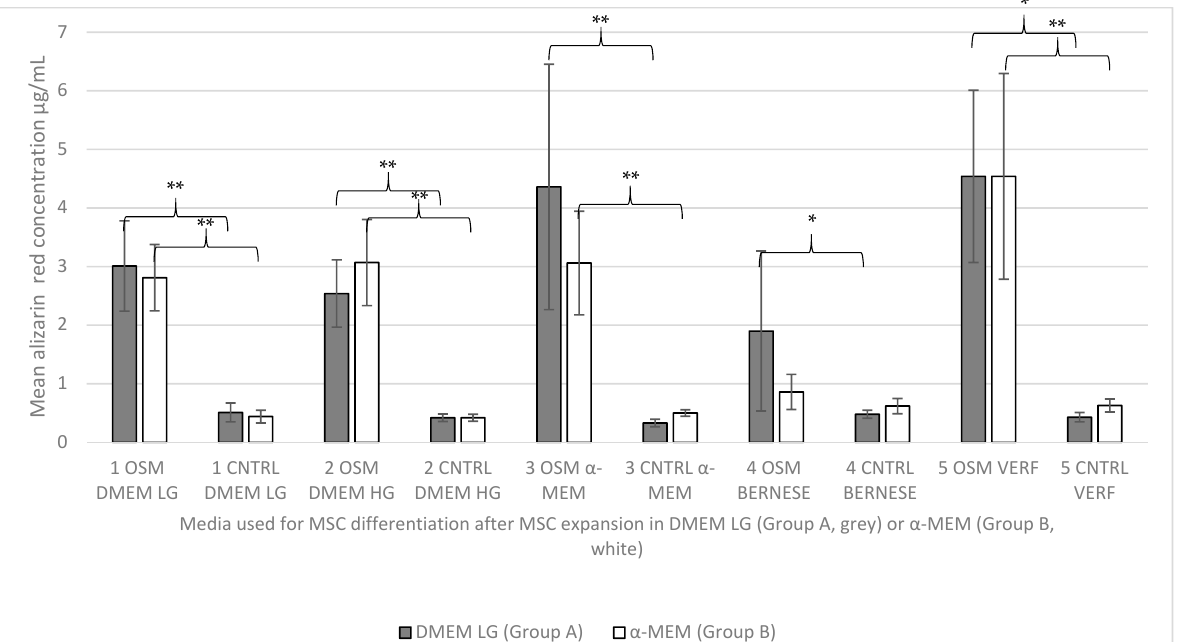
Figure 3. Descriptive statistics for the tracer uptake (gamma count mean values +/- SD) for all groups. The grey bars reflect the use of expansion media A (DMEM LG) and the white bars reflect the use of expansion media B ( α -MEM) prior to differentiation, according to the designated group (1–5). OSM = osteogenic media, CNTRL = negative control group. Significance: ** = p ≤ 0.01; * = p ≤ 0.05.